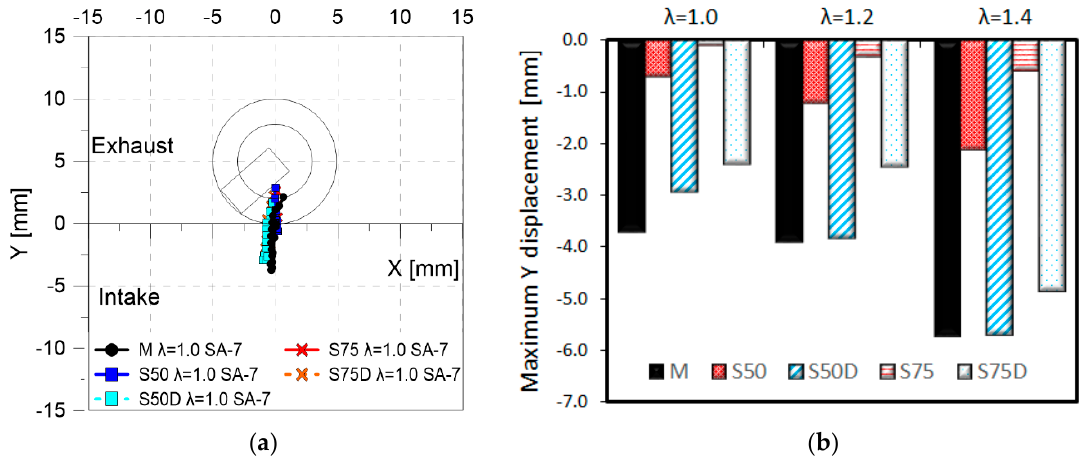
Figure 20. ( a ) Average evolution of flame centroid with respect to the combustion chamber center at a stoichiometric air-fuel ratio ( λ = 1.0) and ( b ) maximum centroid displacement in the vertical direction for all air-fuel ratios.